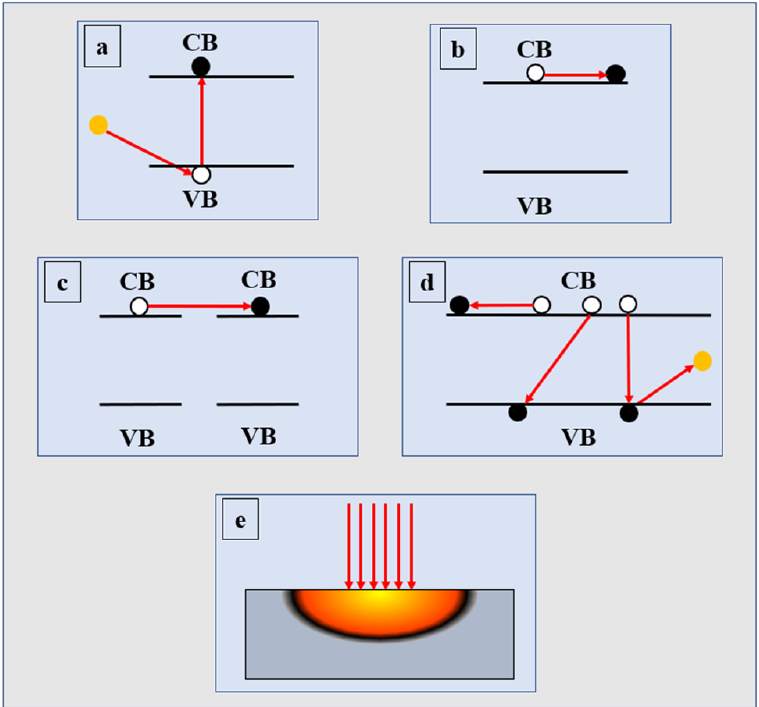
Figure 4. Schematic diagram of laser thermal effect: ( a ) photon absorption and carrier excitation; ( b ) carrier–carrier scattering; ( c ) carrier-phonon scattering; ( d ) carrier recombination; ( e ) thermal effect and thermal